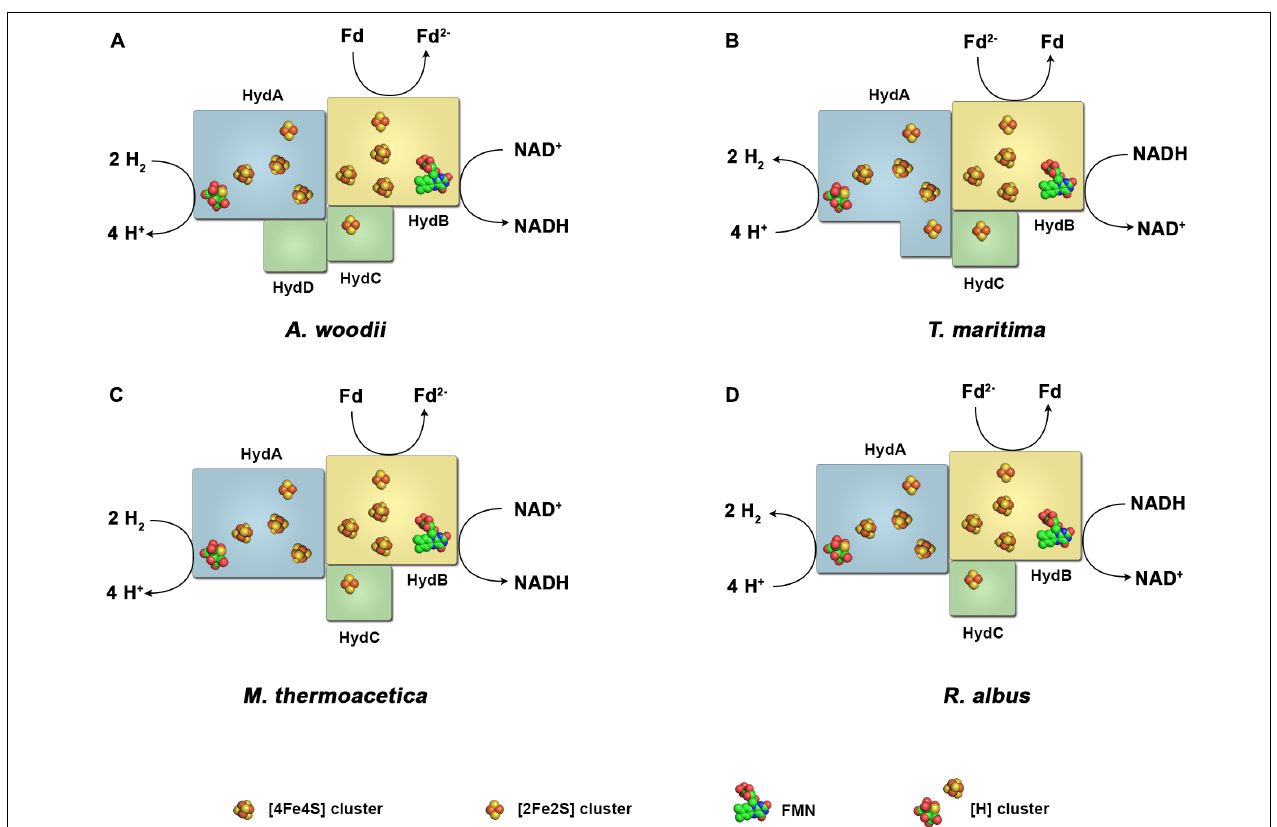
FIGURE 2 | Diversity of the subunit architecture and cofactor content of electron bifurcating and confurcating hydrogenases. Enzymes of this class have been isolated and characterized from A. woodii (A) , T. maritima (B) , M. thermoacetica (C) and R. albus (D) . All enzymes contain the subunits HydA, harboring the active site, the putative flavin-containing and NAD-binding subunit HydB, and the putative electron-transferring subunit HydC. A. woodii contains the additional subunit HydD. The arrangement of the iron–sulfur clusters and the binding site for ferredoxin are chosen arbitrary. Fd,